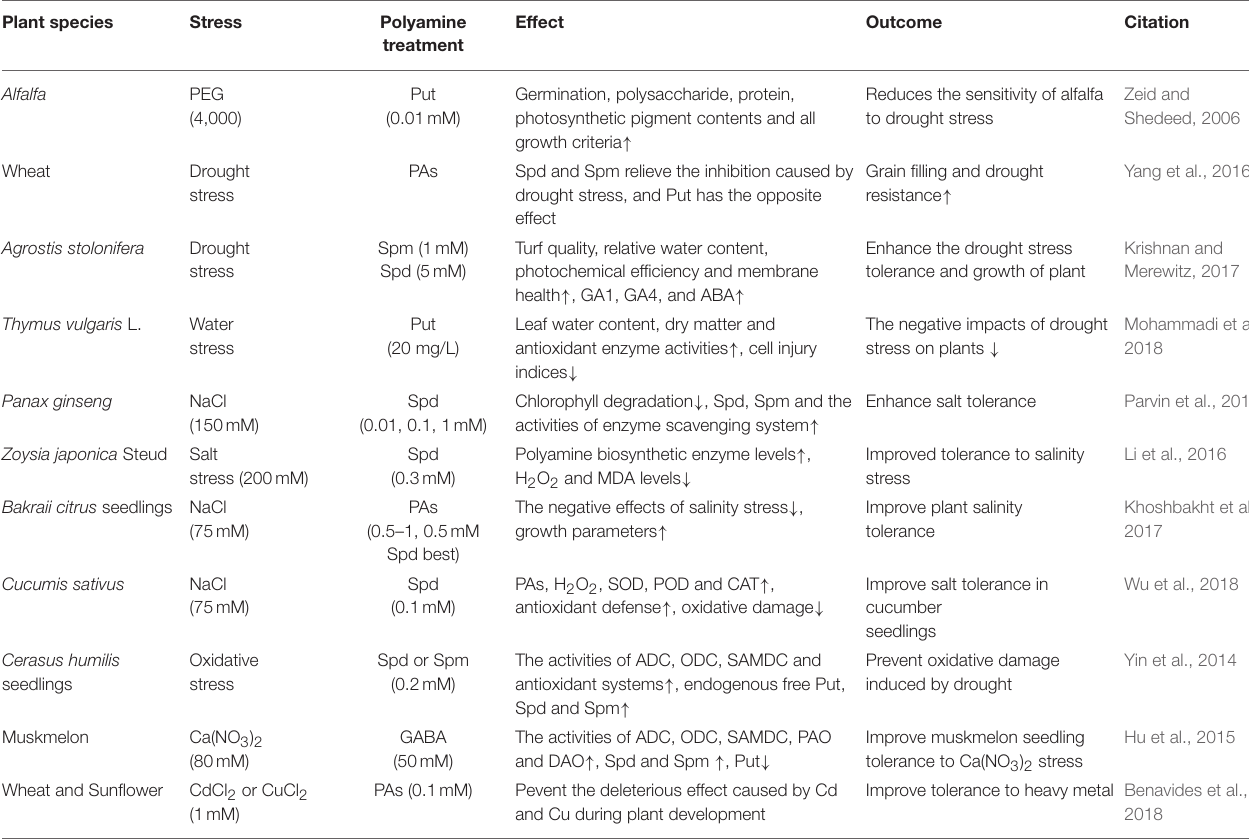
TABLE 4 | Effects of polyamines on plant abiotic stress. Plant